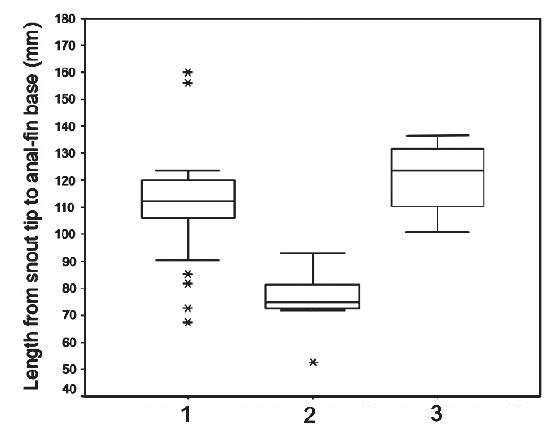
Fig. 2. Length (LEA) medians (horizontal bars), standard de- viations and confidence intervals for Eigenmannia vicentespelaea (n = 25) and Eigenmannia sp. (n = 15) from São Domingos karst area, Central Brazil. *outliers; 1, E. vicentespelaea ; 2, Eigenmannia sp. collected in epigean river; 3, Eigenmannia sp. collected in subterranean stream reaches.